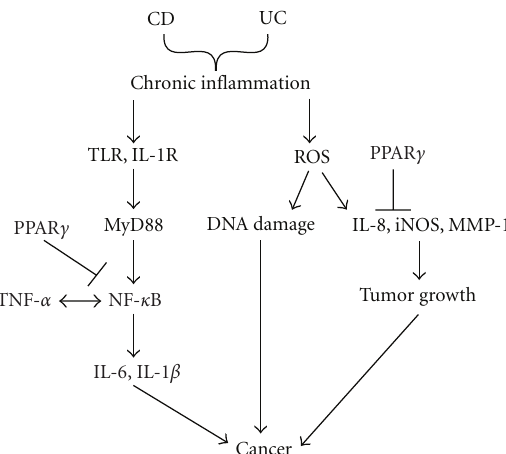
Figure 1: Chronic inflammation activates pathways leading to cancer. Chronic inflammation stemming from ulcerative colitis (UC) and Crohn’s disease (CD), the two clinical manifestations of inflammatory bowel disease, activates nuclear factor- κ B (NF- κ B) downstream of MyD88 through the TLR and IL-1R. In turn, NF- κ B activation increases the expression of pro-inflammatory cytokines IL-6 and IL-1 β . TNF- α also activates NF- κ B which, in turn, increases the expression of TNF- α , leading to a positive feedback loop between TNF- α and NF- κ B. Chronic inflammation also leads to the production of ROS which can damage DNA which can cause mutations responsible for tumorigenesis. ROS also cause the production of IL-8, iNOS, and MMP-1, which promote tumor growth. On the other hand, activation of PPAR γ can block carcinogenesis at two levels: (1) by antagonizing NF- κ B activity and (2) by suppressing IL-8 and iNOS